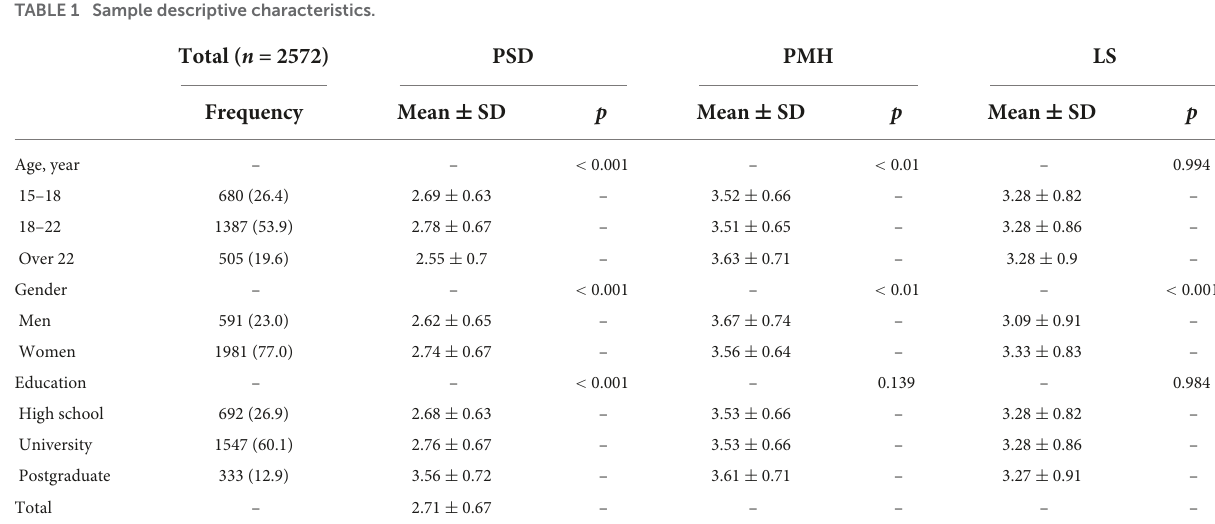
TABLE 1 Sample descriptive